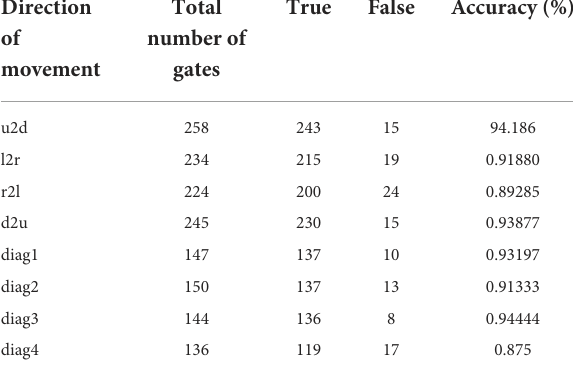
TABLE 2 Implementation of the classifiers on the external control dataset of P3.